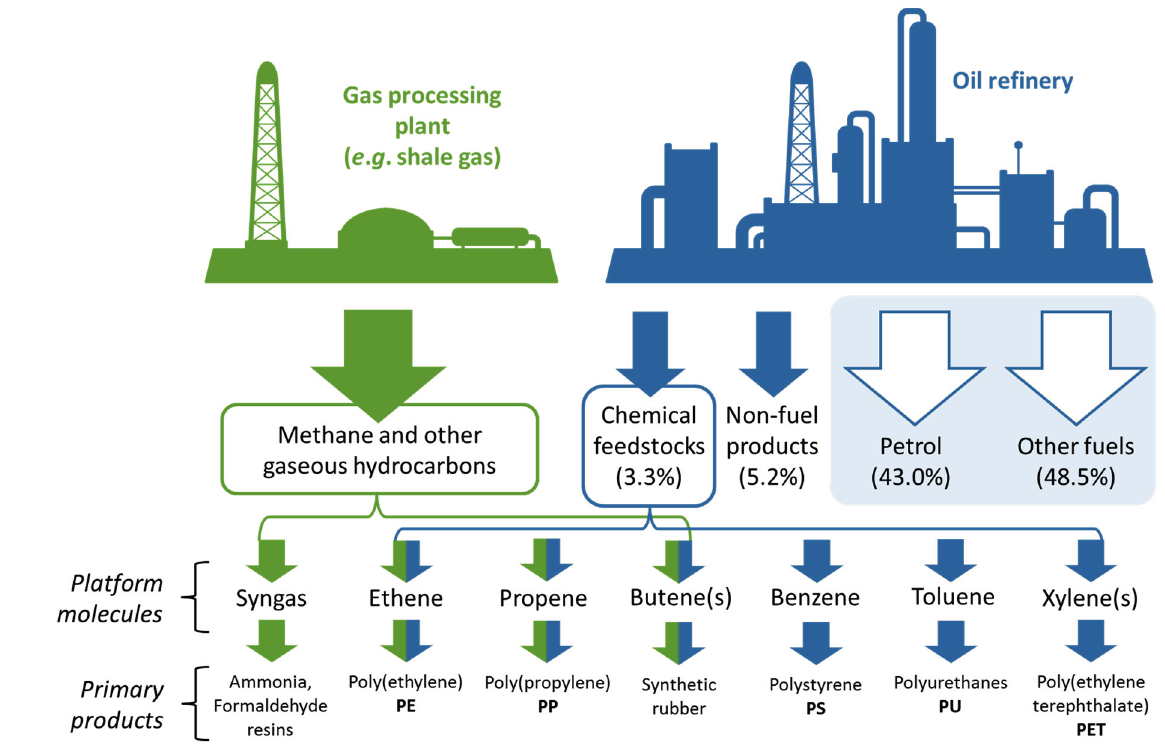
Figure 7. The primary fossil resource refining product